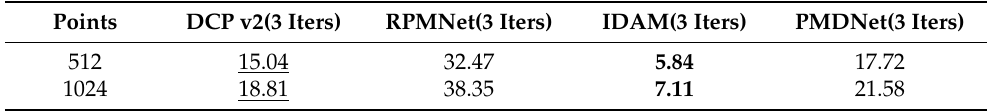
Table 12. Results on time efficiency. Bold and underline denote best and second best performance, respectively. All the results are in the unit of